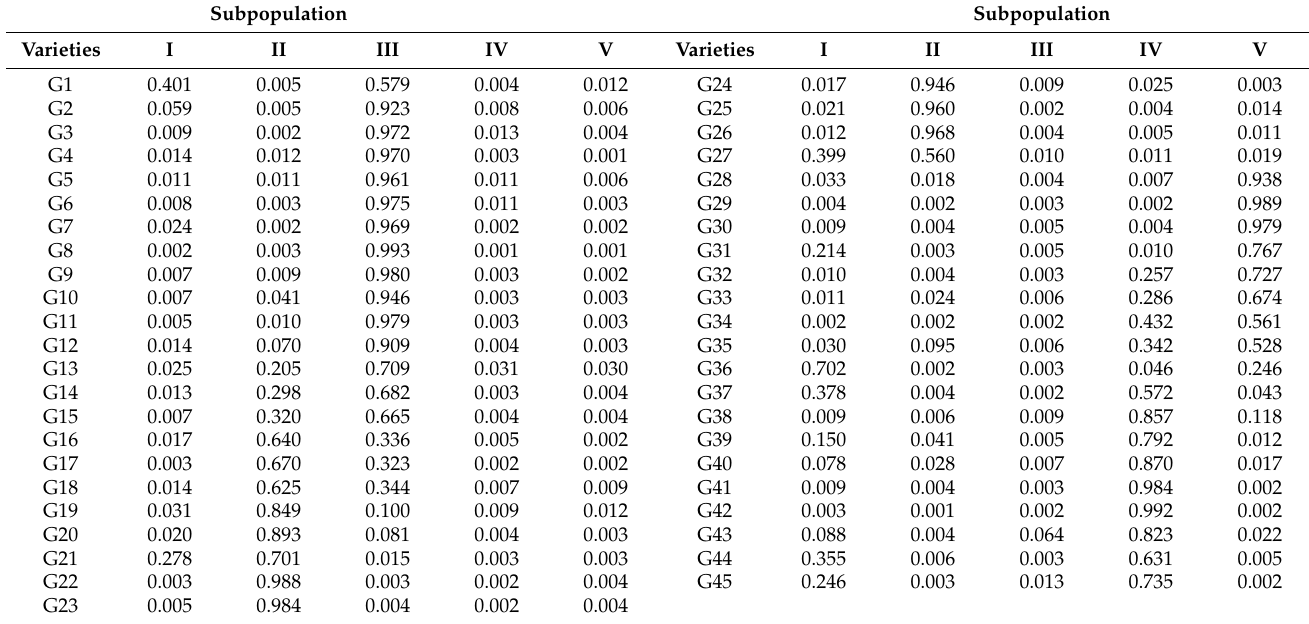
Table 9. Membership coefficients of five subpopulations of bean varieties.